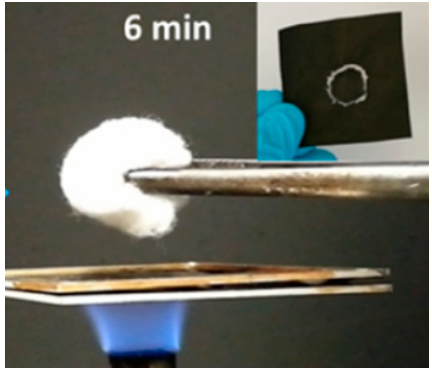
Figure 9. Digital photograph demonstrating the flame-retardant ability of the Hec/BBB membrane. Hec/BBB membrane is brought in contact with a flame and a cotton ball is held on the other side of the membrane. The membrane is demonstrated to block the flame and protect the cotton ball.